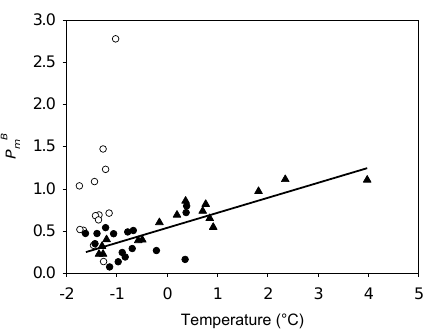
Fig. 5. Relationships between P B m and in situ temperature for spring–early summer (open symbols) and late summer–fall (solid symbols) for surface (triangles) and SCM (circles) communities. The line represents the linear regression for late summer–fall data